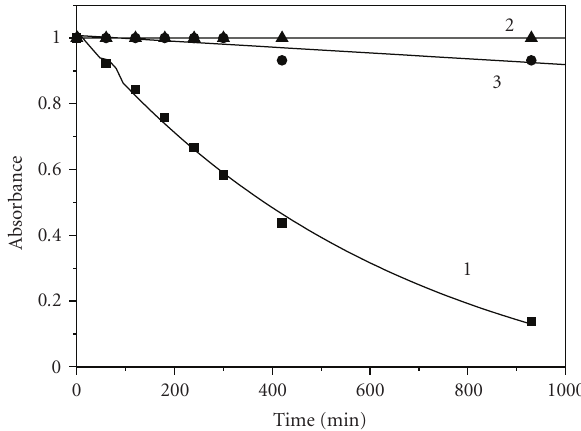
Figure 3: Photodegradation curves of AZS with black light illumination: in the presence of TiO 2 films (1); in the absence of photocatalyst (2); and in the absence of oxygen